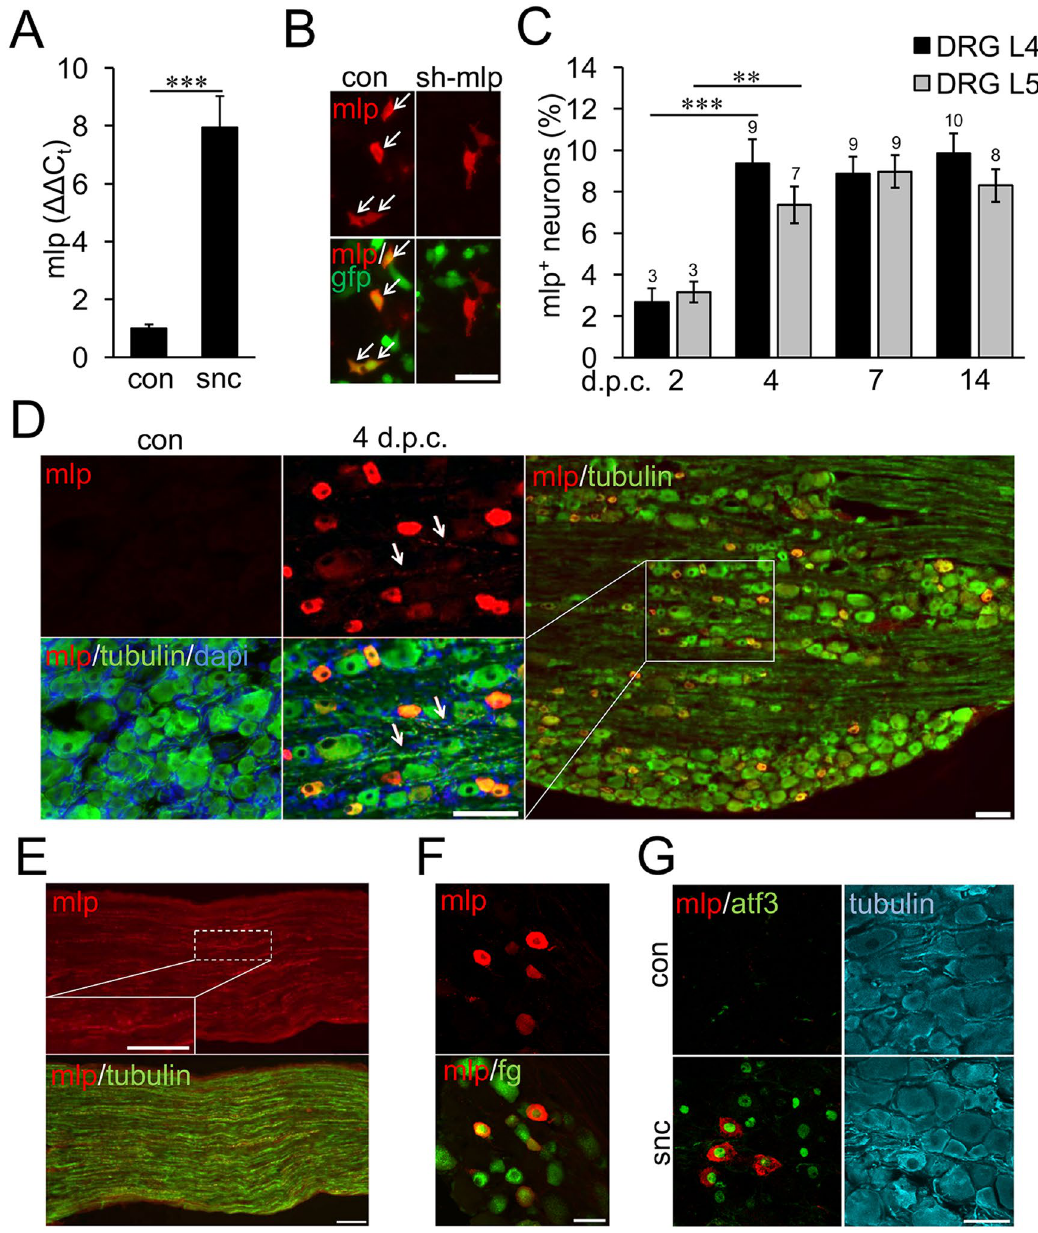
Figure 1. MLP is expressed in a subpopulation of DRG neurons. ( A ) Quantitative RT-PCR reveals strong induction of Mlp expression in adult male rat L4/L5-DRG 7 days after sciatic nerve crush (snc) in comparison to sham-operated controls (con). Samples of 3 animals per group (snc and con) were used. The Ct values for Mlp were in the range of 24 to 30 cycles and the Ct values for Gapdh of 18–19 cycles. Treatment effect: *** p < 0.001. ( B ) HEK293 cells were co- transfected with MLP expression plasmid and either scrambled control shRNA (con) or Mlp-shRNA (sh-Mlp). GFP expression indicates shRNA-transfected cells and MLP was detected 24 hours after transfection. Mlp-shRNA knocked down MLP expression. Scale bar: 50 µ m. ( C ) Quantification of MLP-positive (mlp + ) L4 and L5 DRG neurons at 2, 4, 7 and 14 days post sciatic nerve crush (d.p.c.). Data represent mean percentages ± SEM of all β III-tubulin-stained neurons on DRG sections as in ( D ). Two male rats and 4 sections per DRG were used for each group. Treatment effects: ** p < 0.01, *** p < 0.001. ( D ) Immunohistochemical analysis of MLP expression on DRG sections of sham-operated controls (con) and 4 d.p.c. The sections were stained for MLP (red), β III-tubulin (green) and DAPI (blue). MLP was detected in a subpopulation of β III-tubulin-positive neurons and their axons (arrows). Scale bars: 50 µ m. ( E ) MLP expression (red) was also detected in β III-tubulin-positive axons (green) on proximal sciatic nerve sections at 4 d.p.c. The insert shows a higher magnification of a MLP-positive axon. Scale bars: 100 µ m. ( F ) MLP immunostaining on DRG sections 7 days after sciatic nerve cut and retrograde fluorogold (fg) labeling. MLP expression was only detected in fg-positive injured neurons. Scale bar: 50 µ m. ( G ) DRG sections of sham-operated controls (con) and 4 d.p.c were stained for MLP (red), ATF3 (green) and β III-tubulin (cyan). ATF3 expression indicated axotomized DRG neurons. MLP was only detected in ATF3-positive neurons. Scale bar: 50 µ